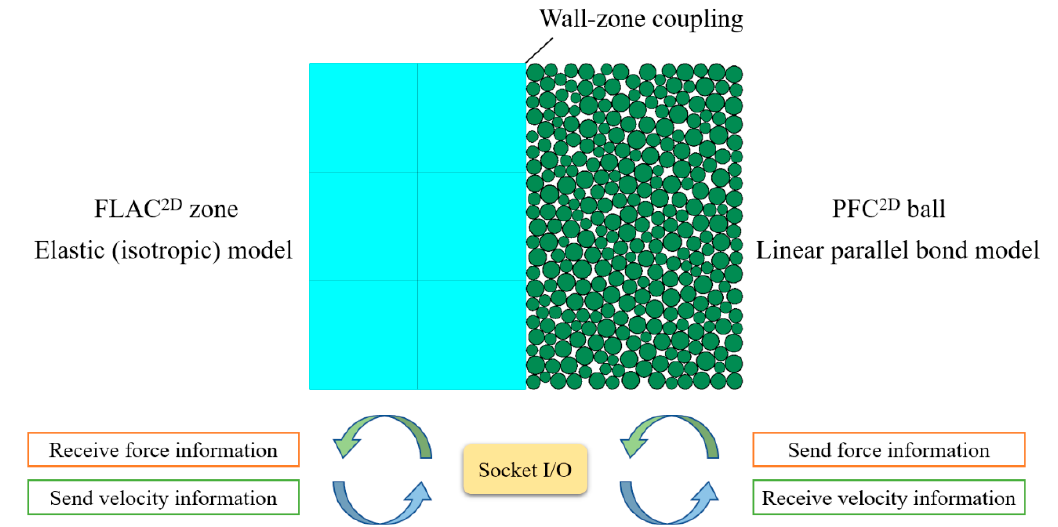
Figure 4. Coupling Mechanism Based on FLAC 2D and PFC 2D .